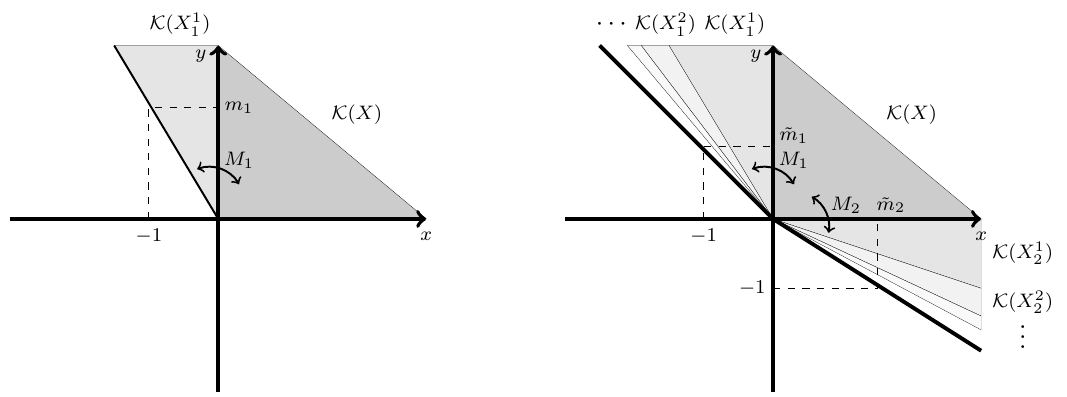
) with involution generated 1